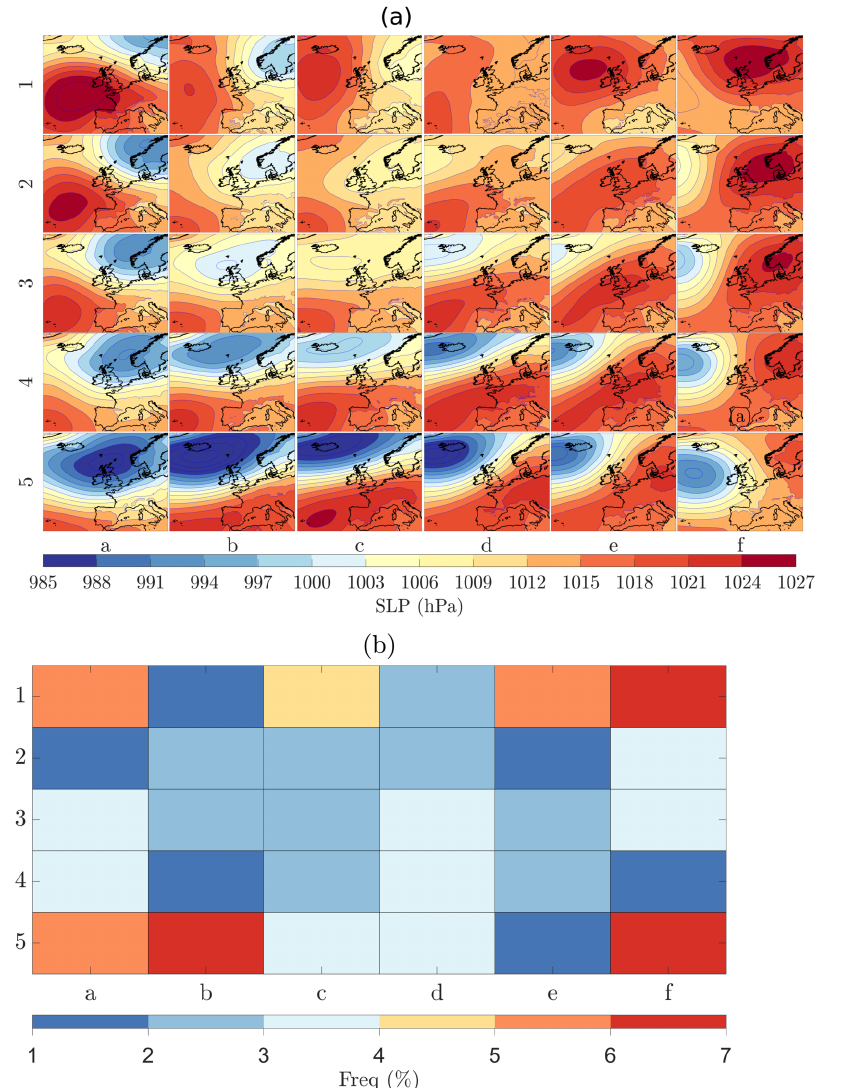
Figure 4. The SOM-based weather patterns using ERA5 hourly sea level pressure 2003–2017 and corresponindg frequency of occurrence: ( a ) The SOM-based weather patterns. The color scale is hourly sea level pressure (SLP) in hPa and the contour lines are at intervals of 3 hPa; and ( b ) frequency of weather patterns in (%). Rows (1–5) and columns (a–f) are used to label the weather